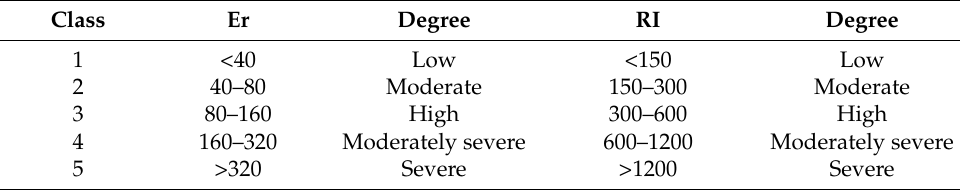
Table 4. Contamination levels based on potential ecological risk